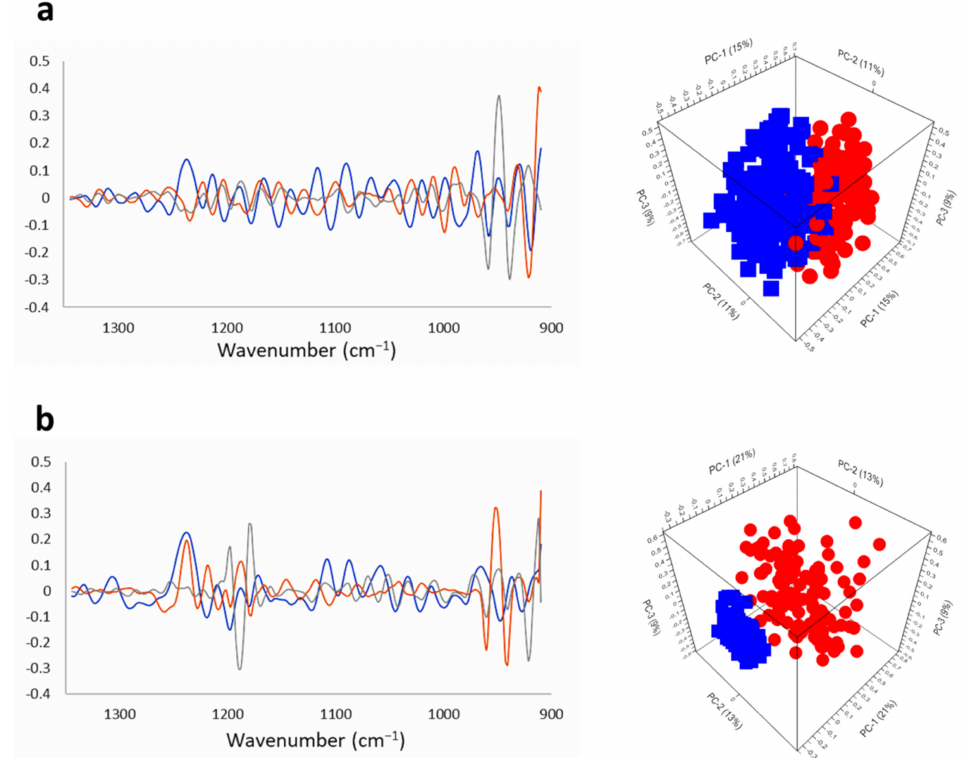
Figure 7. PCA and loadings within the DNA region (1350–900 cm − 1) of GICs samples treated with Na[ o -COSAN] 200 µ M, 5 h: ( a ) GIC7 and ( b ) PG88 cells. Principal component loadings (blue PC-1, orange PC-2, grey PC-3) are shown on left panels. Right-panels principal component analysis score plots of PC-1, PC-2 and PC-3 displaying the variance between GIC control cells (blue) and GIC treated cells